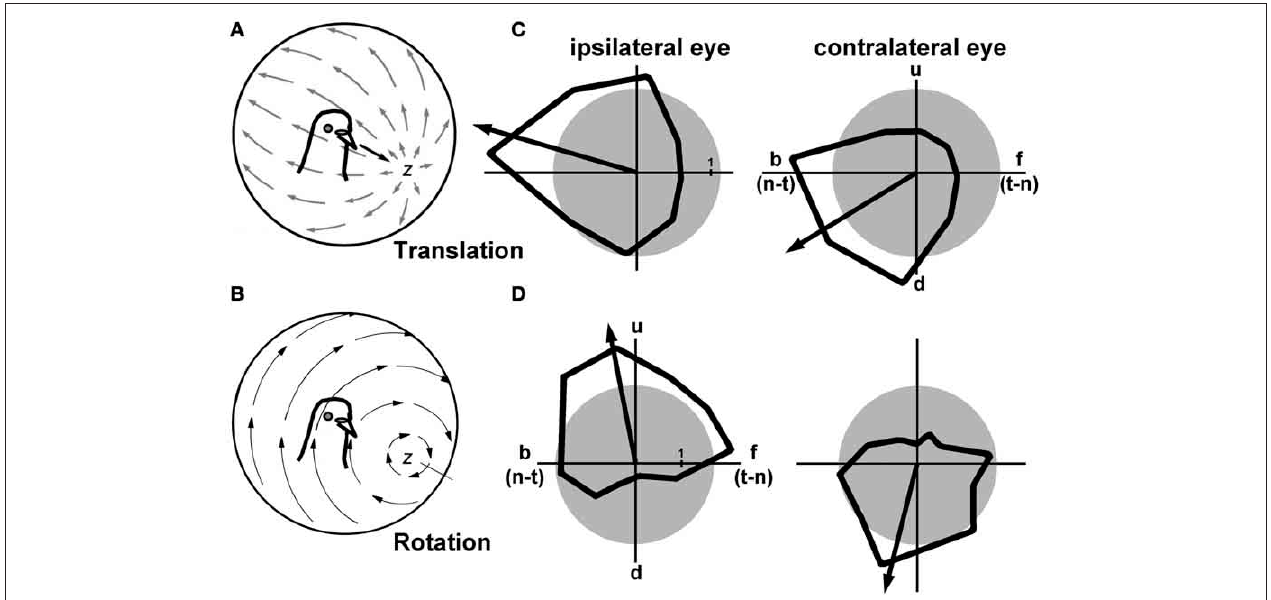
The cell in (C) preferred backward (b) [i.e., nasal-to-temporal (n-t)] motion in both eyes, which would result from forward self-translation (adapted from Graham and Wylie, 2012). The cell in (D) preferred upward (u) motion in the ipsilateral eye, and downward motion in the contralateral eye, which results from rotation of the head about the z-axis (roll) (adapted from Wylie and Frost, 1991). The gray circles represent the spontaneous firing rates of these neurons, which is typically about 1 spikes/s. d: downward motion; f: forward motion [i.e., temporal-to-nasal